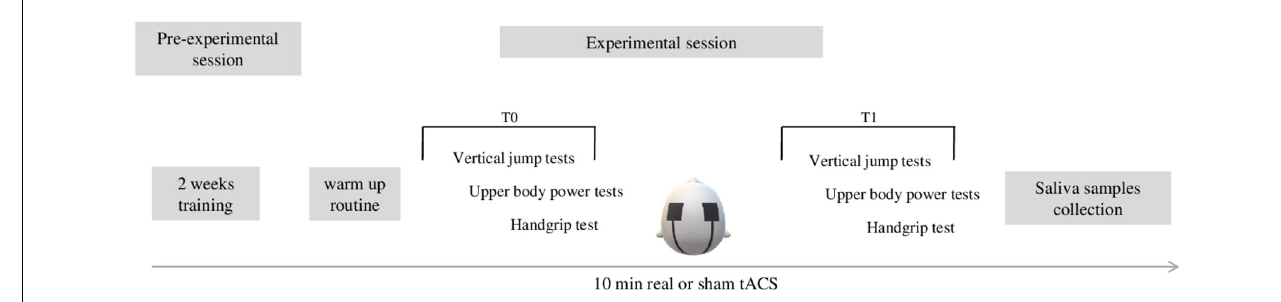
FIGURE 1 | The figure shows the experimental procedure. Before the experimental session, subjects performed 2 weeks (two sessions/week) of training. The experimental session lasted approximately 1 h and included 2–3 min of warm up routine consisting of light jogging, 20 min of execution of the experimental physical tests (t0), 10 min of real or sham-tACS, and a new assessment of performance of physical tests (20 min). Afterward, saliva samples were collected from each participant.